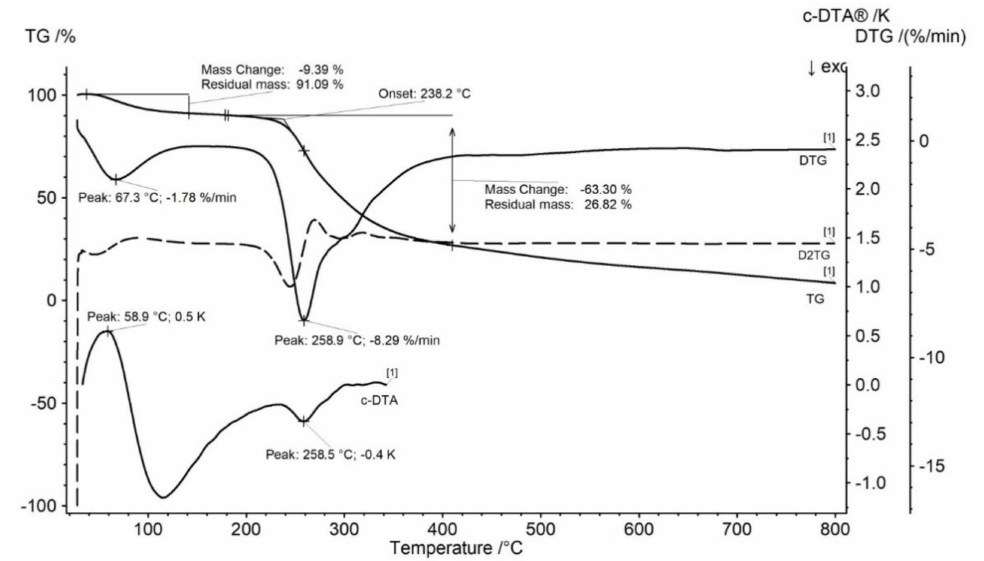
Figure 2. TG, DTG, D2TG, and c-DTA curves of gum tragacanth (GT). Curves recorded for dynamic thermogravimetric